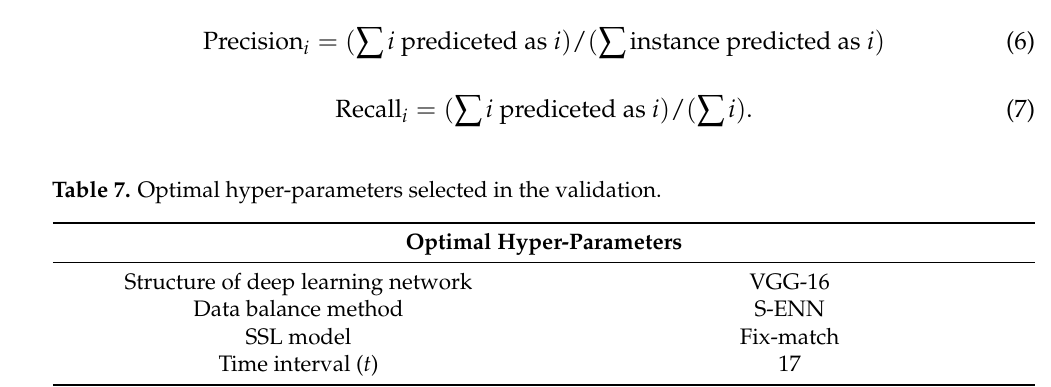
Table 7. Optimal hyper-parameters selected in the validation.